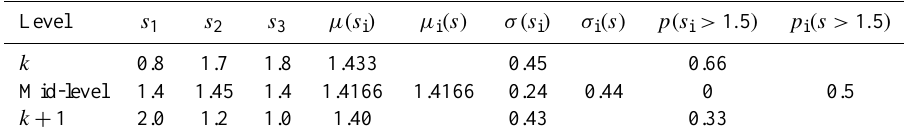
Figure 18. Distribution of errors due to vertical linear interpolation (denoted by interp (cid:49) ) of statistical quantities. (a) Distribution of errors of σ( | v | ) (top), and vertical occurrence of the errors (bottom). (b) The same for p( | v | > 20ms − 1 ) . (c) Vertical profile of level average differences due to regridding (crosses) and interpolation (dots). Same forecast as in Fig. 13. Table 3. Example of vertically interpolating statistical quantities. Consider an ensemble of three members and corresponding scalar quantities s 1 .. s 3 at the two vertical levels k and k + 1. While the mean value µ(s) , interpolated to the mid-level between k and k + 1, equals the mean of the interpolated scalar values, this is not true for the SD σ(s) and the probability that a scalar value exceeds 1.5, p(s > 1 . 5 ) . The subscript i refers to